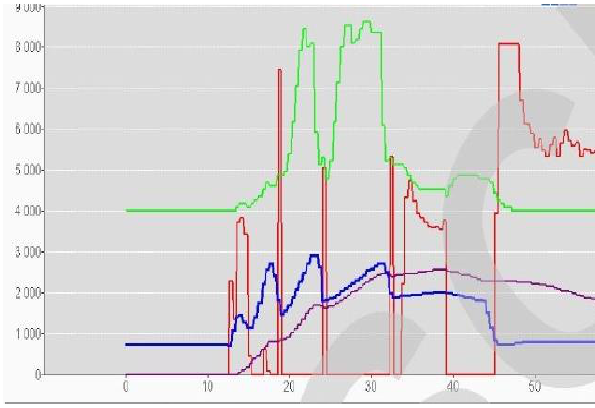
Fig. 2. Record of real parameters during traction test as a function of time (s). Markings: engine speed – blue line, fill factor for the exhaust gas recirculation valve (recirculation level) – red line, boost pressure – green line, car speed – purple